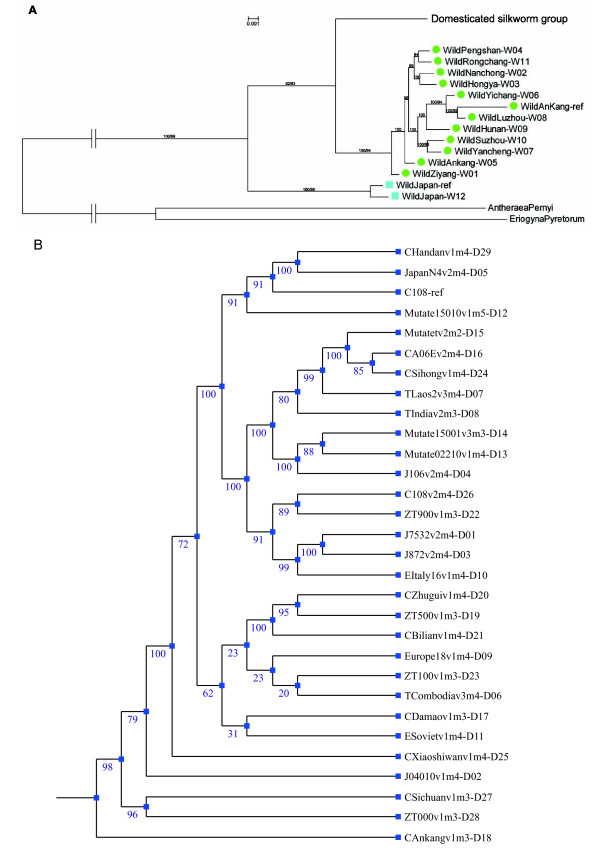
Silkworm mitochondrial phylogeny. (A) Phylogeny in different silkworm groups, based on whole mitochondrial genome. The tree was built using Bayesian method with GTR+gamma+I model. Bootstrap values measured by the posterior probabilities are shown at the nodes. We also reconstructed a Neighbour-joining tree in Mega, using the same consensus sequence. The support values (with 1000 bootstrap replicates) are listed following the posterior probabilities. Except for the outgroup Antheraea pernyi and Eriogyna pyretorum, as well as the domesticated group, each sample is represented by a combination of symbols representing respective silkworm groups (filled circles for Chinese wild group and boxes for Japanese wild group), sample names and sample IDs ("W01" to "W12", "WildAnKang-ref" for the reference genome of Chinese wild group, "WildJapan-ref " for the reference genome of Japanese wild group). The detailed information for samples could be found in Table 1. (B) More fine scale phylogeny for the domesticated silkworm using Mrbayes. For the tree has a very short branch length, only topology was shown in this picture. The posterior probabilities are listed at each node. Each sample is represented by sample names and sample IDs ("D01" to "D29", "C108-ref" for the reference genome of domesticated group).